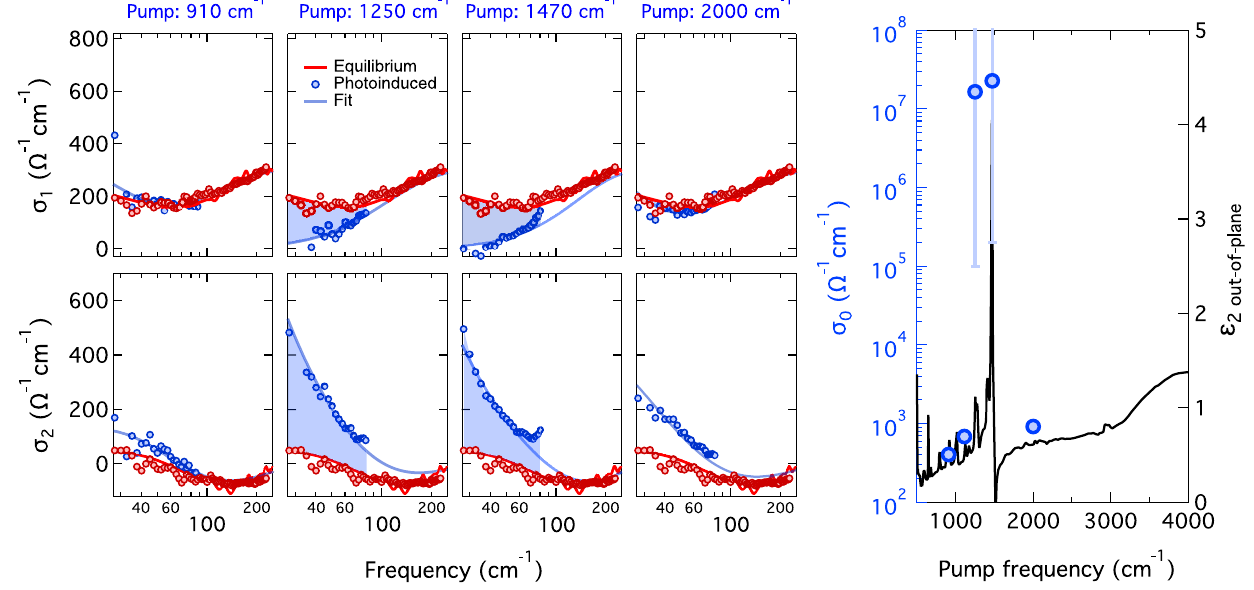
FIG. 6. Left panels: In-plane complex optical conductivity of κ - ð ET Þ 2 Cu ½ N ð CN Þ 2 (cid:3) Br measured at T ¼ 50 K in equilibrium (red circles) and at τ ≃ 1 ps time delay after photoexcitation (blue circles) at four different pump frequencies: ν pump ¼ 11 μ m Þ , ν 1250 cm − 1 ð λ 8 μ m Þ , ν 1470 cm − 1 ð λ 6 . 8 μ m Þ , and ν 2000 cm − 1 910 cm − 1 ð λ pump ¼ pump ¼ pump ¼ pump ¼ pump ¼ pump ¼ ð λ pump ¼ 5 μ m Þ . Lines are corresponding fits performed with a Drude-Lorentz model. The ν pump ¼ 2000 cm − 1 spectra display an enhancement of σ 2 ð ω Þ in the absence of a gap opening in σ 1 ð ω Þ . This is indicative of a slight increase in metallicity, with no superconducting-like response. All data have been taken with a constant pump fluence of 2 mJ = cm 2 . Right panel: Zero-frequency extrapolation of the transient optical conductivity, σ 0 ¼ σ 1 ð ω Þj ω → 0 (see main text), extracted from the spectra on the left for different 1100 cm − 1 ð λ 9 μ m Þ is also reported, for which the transient pump wavelengths (blue circles, left scale). A data point at ν pump ¼ pump ¼ 910 cm − 1 (negligible pump-induced effect). The equilibrium out-of-plane imaginary dielectric spectra look identical to those at ν pump ¼ function [14] is also displayed (black line, right scale) to visualize the resonant photoconductivity behavior on the C ═ C ET